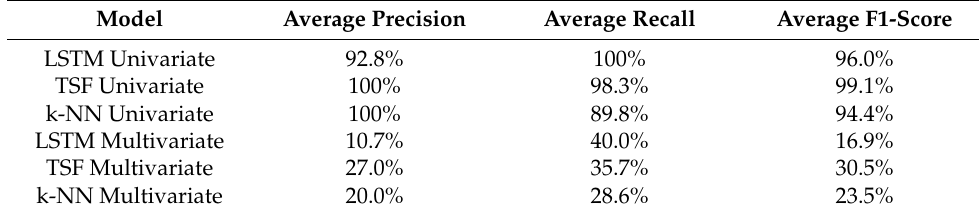
Table 15. Performance Parameters for IOC Classification. Model Average Precision